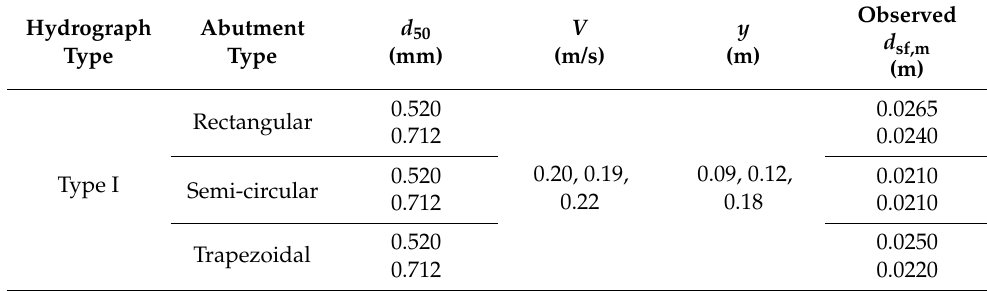
Table 1. Summary of experimental conditions under clear water with unsteady